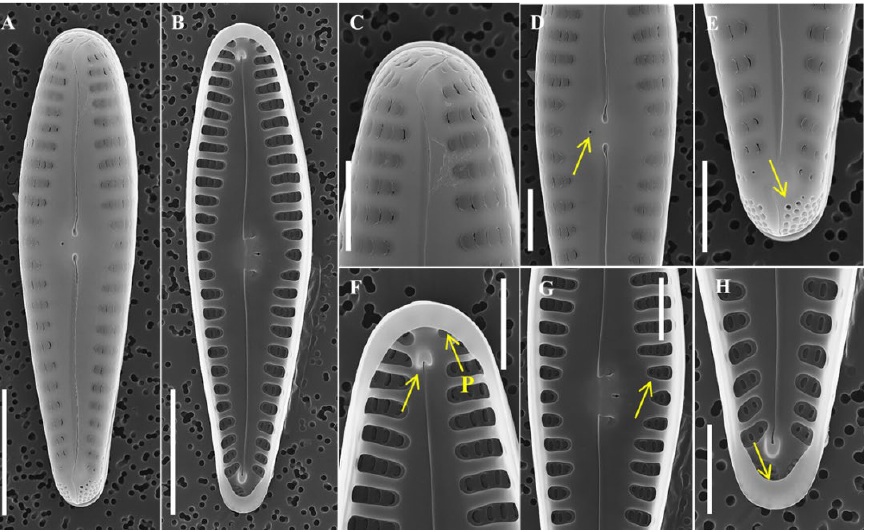
Figure 7. SEM of Gomphonema seminulum sp. nov. taken from holotype population (AG9005): ( A , B ) scale bar = 5 µm; ( C – H ) scale bar = 2 µm; ( A ) external view of whole valve; ( B ) internal view of whole valve; ( C ) external view of head pole; ( D ) external view of valve middle, showing the stigma on central area of valve face (arrow); ( E ) internal view of foot pole, showing the apical pore field (arrow); ( F ) internal view of head pole, showing the helictoglossa (arrow), pseudosepta (arrow P); ( G ) internal view of valve middle, showing the alveoli (arrow); ( H ) internal view of foot pole, showing the pseudosepta (arrow).